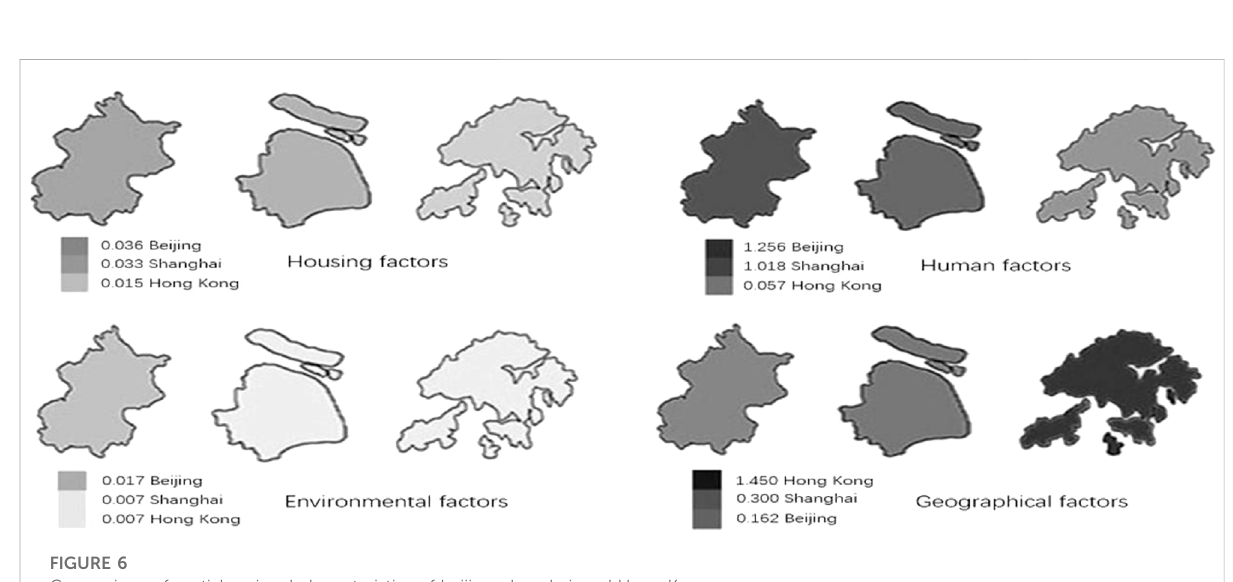
FIGURE 6 Comparison of spatial regional characteristics of beijing, shanghai, and Hong